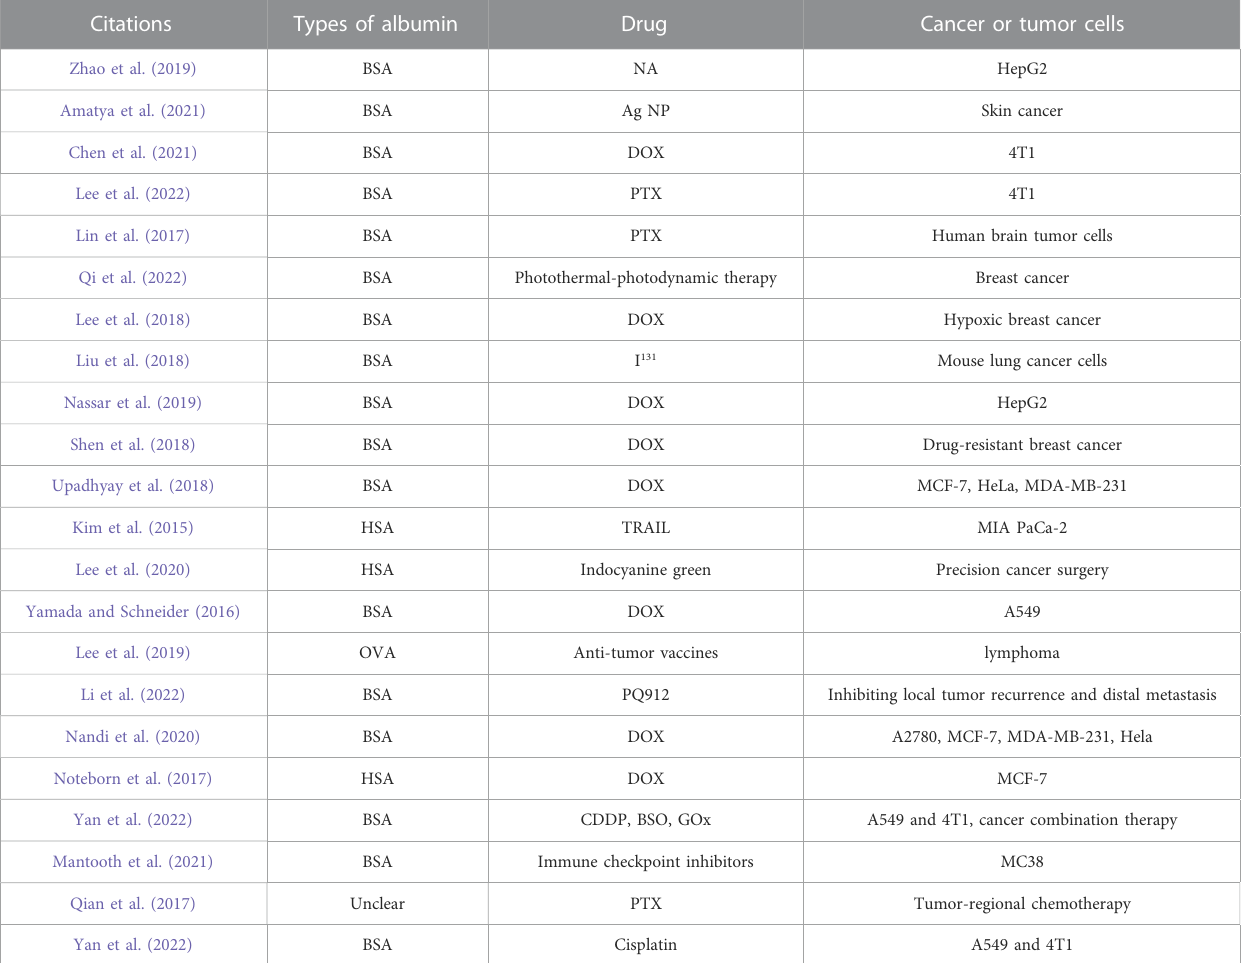
TABLE 2 Applications of albumin-based hydrogels in cancer therapy